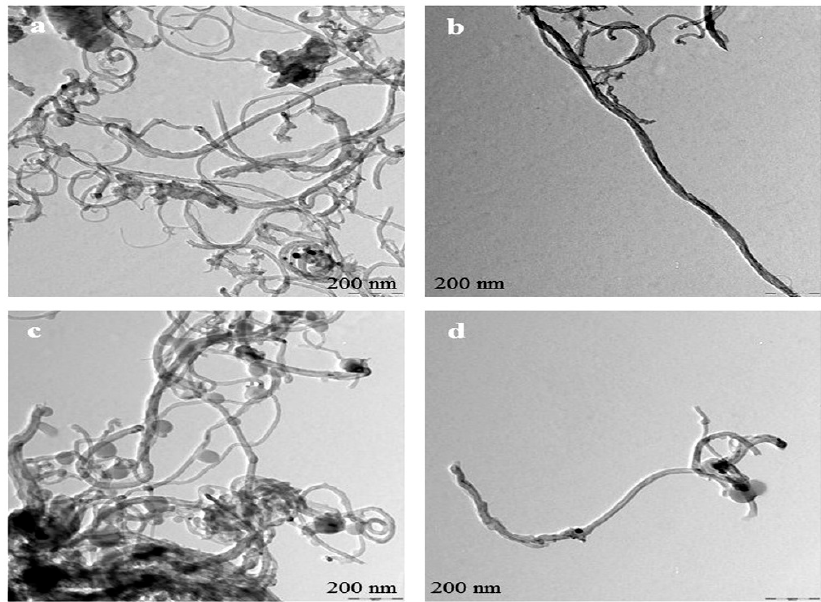
Figure 10. Transmission electron microscopy (TEM) images of ( a ) pure DWCNTs, ( b ) SDBS-treated DWCNTs, ( c ) pure MWCNTs, and ( d ) SDBS-treated MWCNTs.